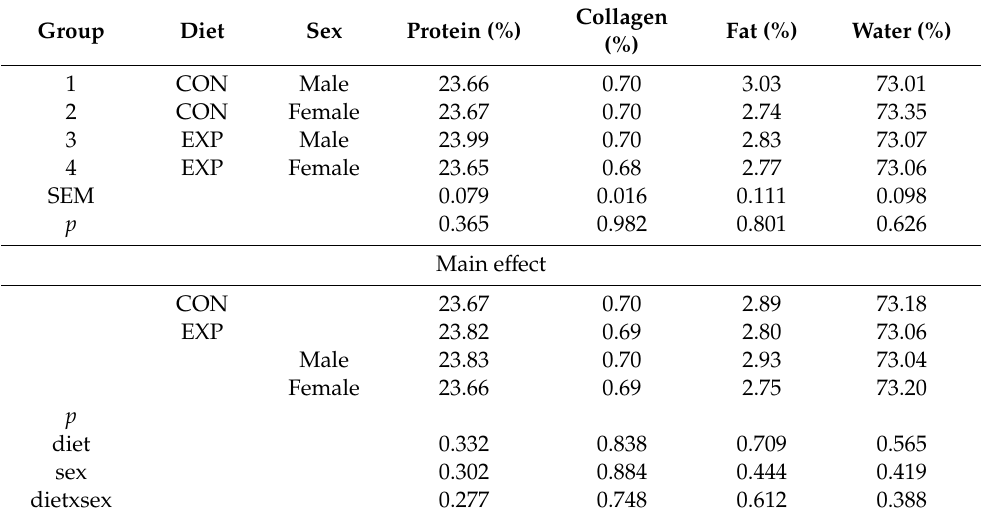
Table 6. The chemical composition of